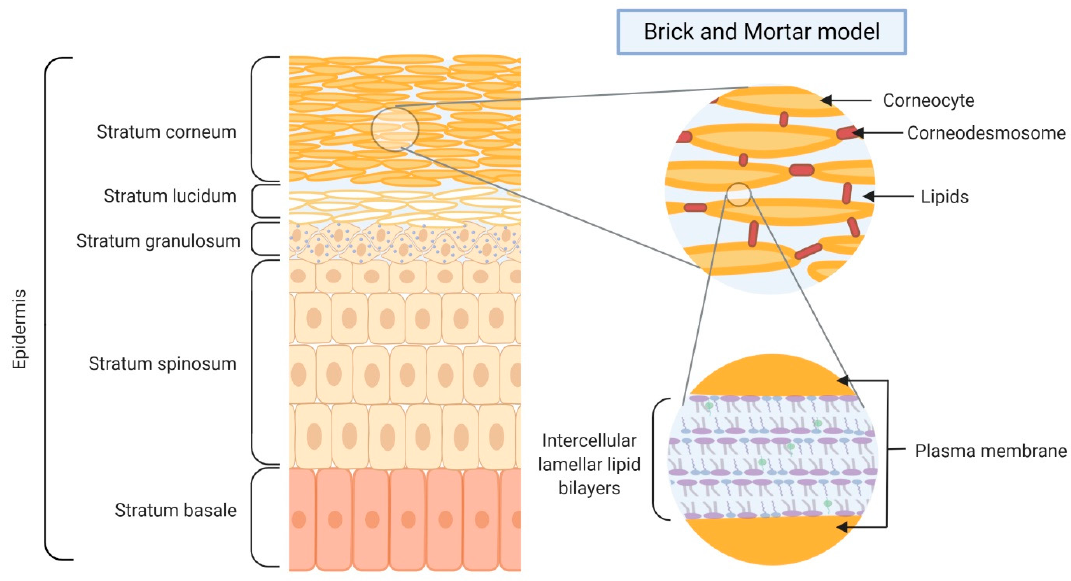
Figure 2. Schematic structure of the skin barrier and “brick and mortar”